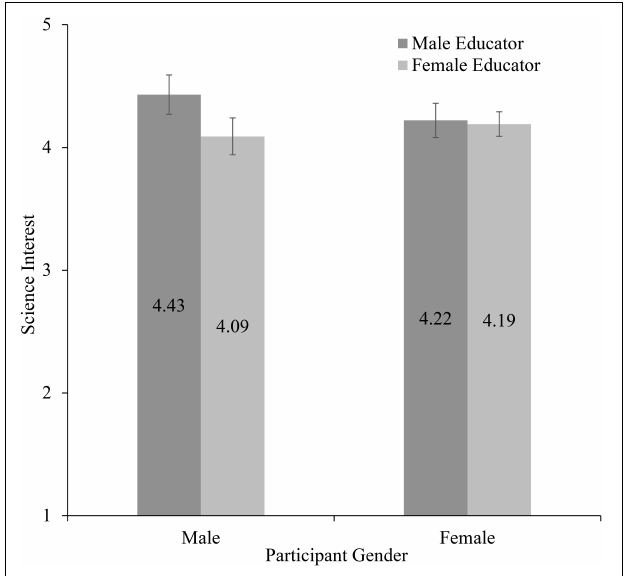
FIGURE 3 | Science interest as a function of participant gender and educator gender (w. standard error bars).